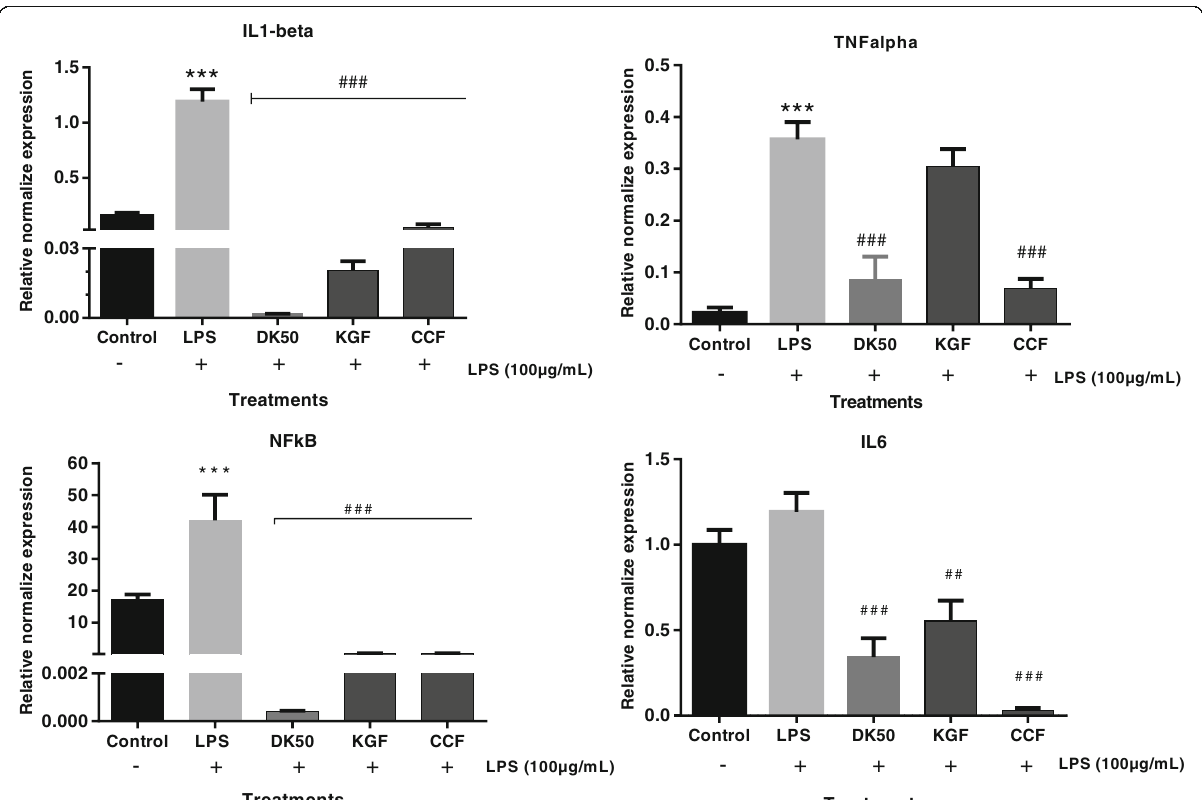
Fig. 5 Normalised gene expression levels of proinflammatory cytokines in LPS induced U87-MG cell lines (n = 3). The mRNA expression values were given as mean ± SEM normalised to GAPDH levels in each sample. Y-axis values represent the number of mRNA copies relative to the number of GAPDH copies. Control-untreated cell line; LPS (100 μ g/mL), K. grandifoliola stem bark (FKG) and C. citratus leaves (FCC) were tested at 12.5 μ g/mL, DK50-Diclofenac potassium 50 μ g/mL treated cells. Data are expressed as mean ± SEM. #, ##, ### denote statistical significance at p < 0.05, p < 0.01 & p < 0.001 in comparison to the LPS treated group. *, **, *** denote statistical significance at p < 0.05, p < 0.01 & p < 0.001